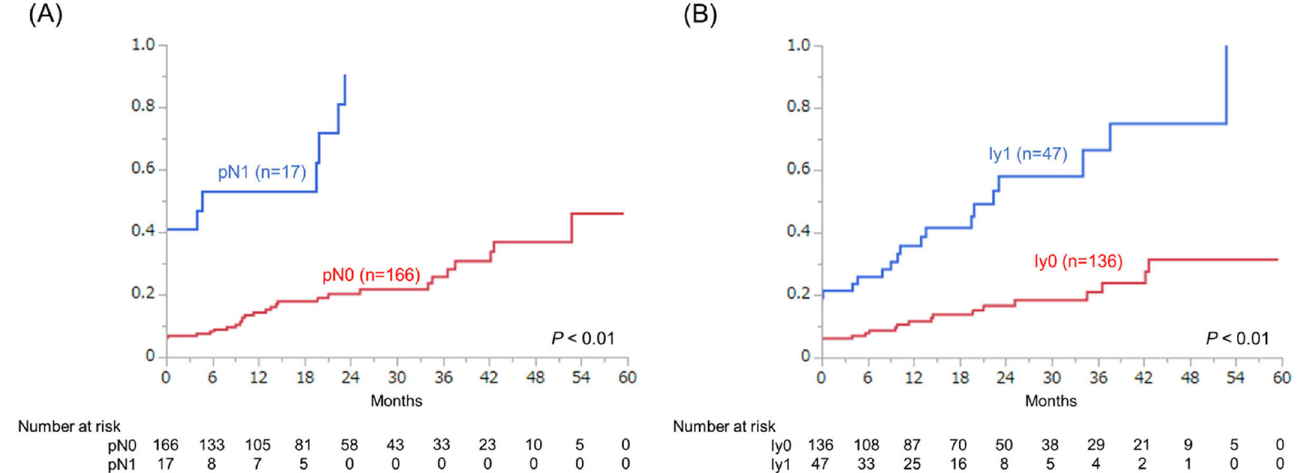
Figure 1. Kaplan–Meier analyses of BCR rates according to the presence of ( A ) nodal metastasis and ( B ) lymphatic invasion.